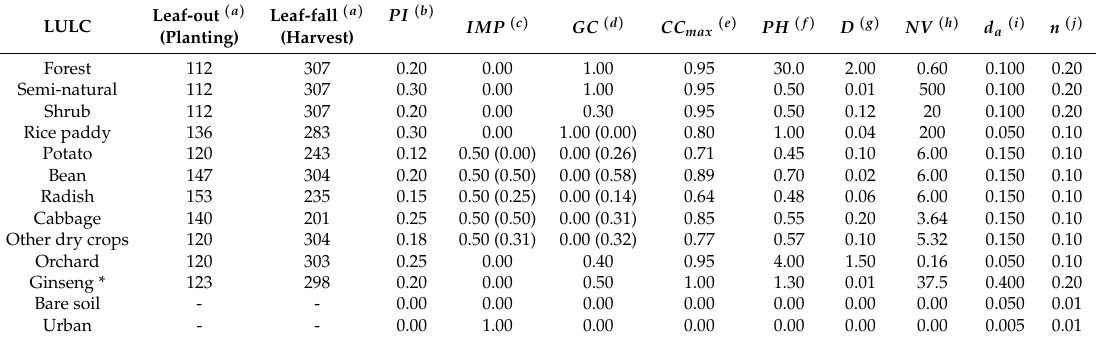
Table 3. The initial parameter settings for each LULC